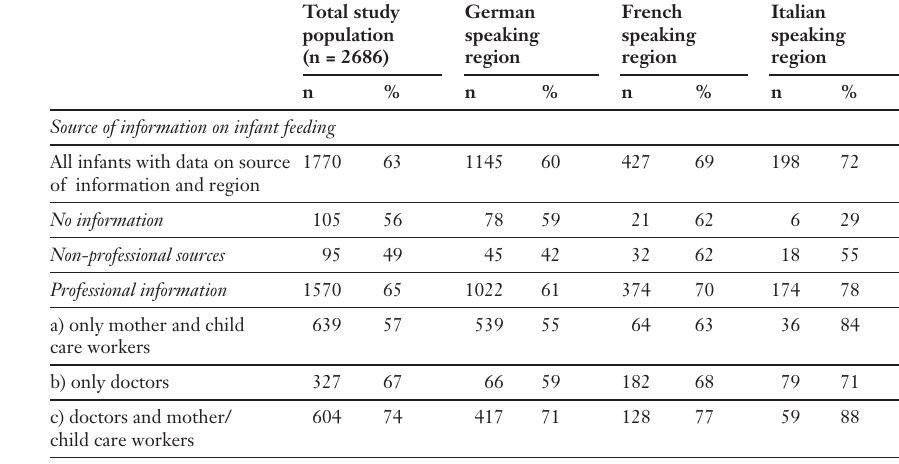
Unadjusted preva- lences of vitamin D supplementation by source of infor-